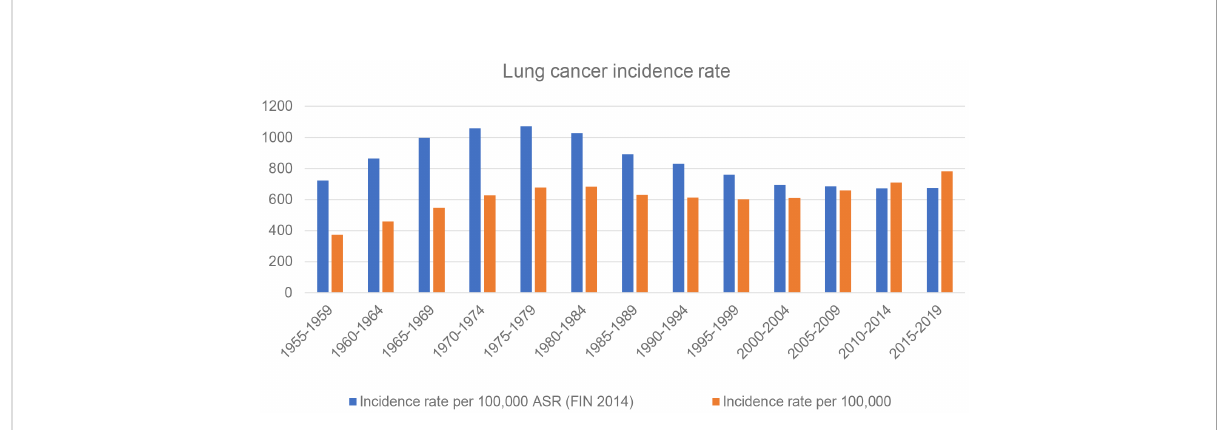
FIGURE 3 Lung cancer incidence rates in radon-exposed municipalities in Finland from 1955 to 2019. The number of new cancer cases per 100,000 people per year, if the age structure of the population remains similar to that in Finland in 2014. The number of new cancer cases per 100,000 people per year.